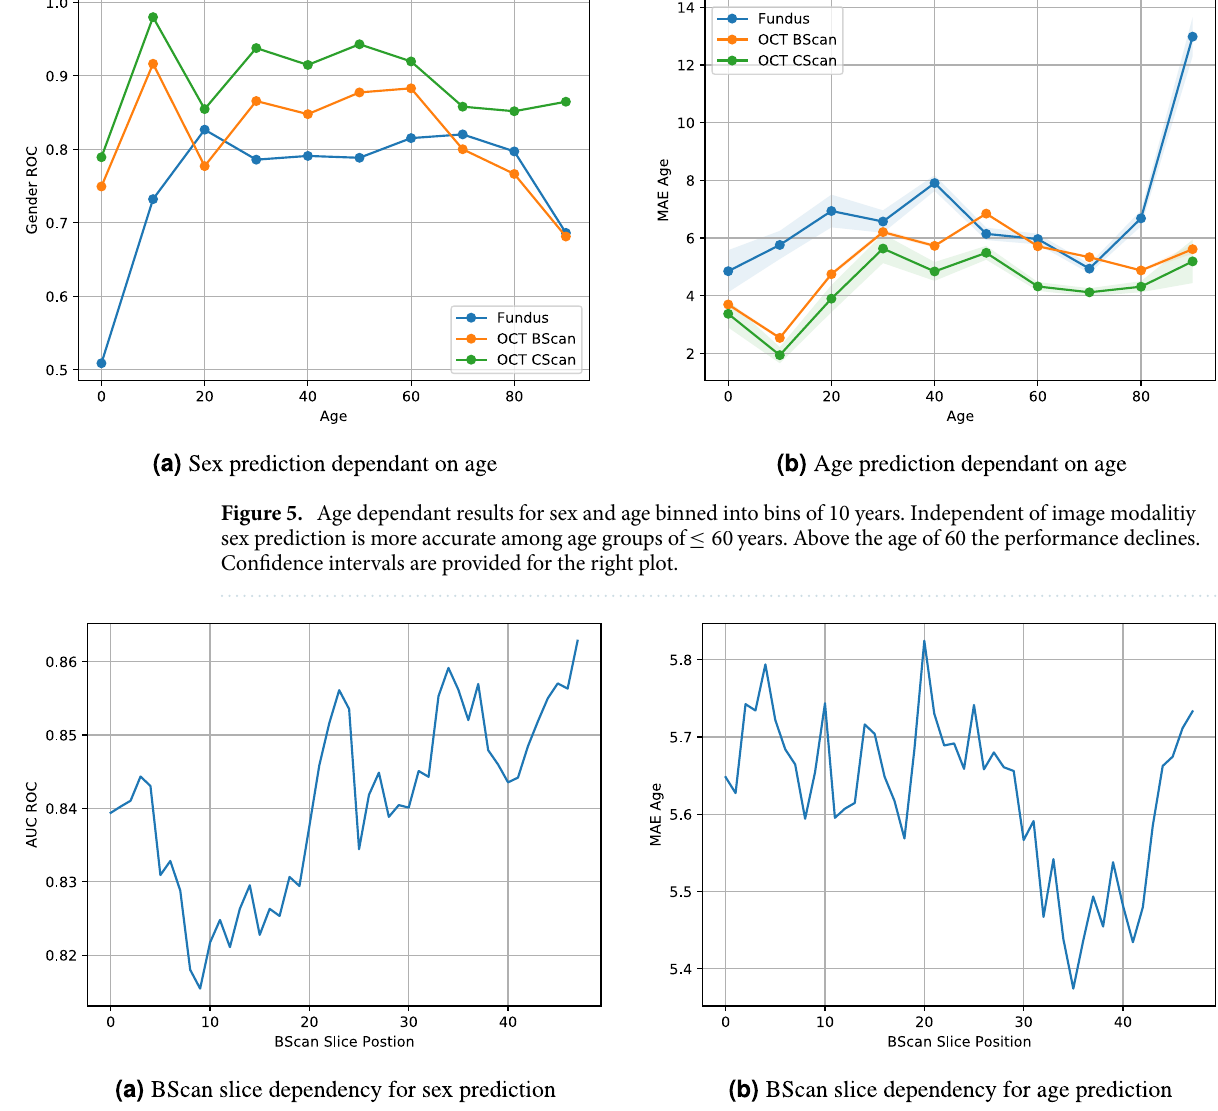
Figure 6. Analysis of the dependency of BScan slice position in CScans and resulting performance. Central foveal scans show a more precise prediction of sex and age,